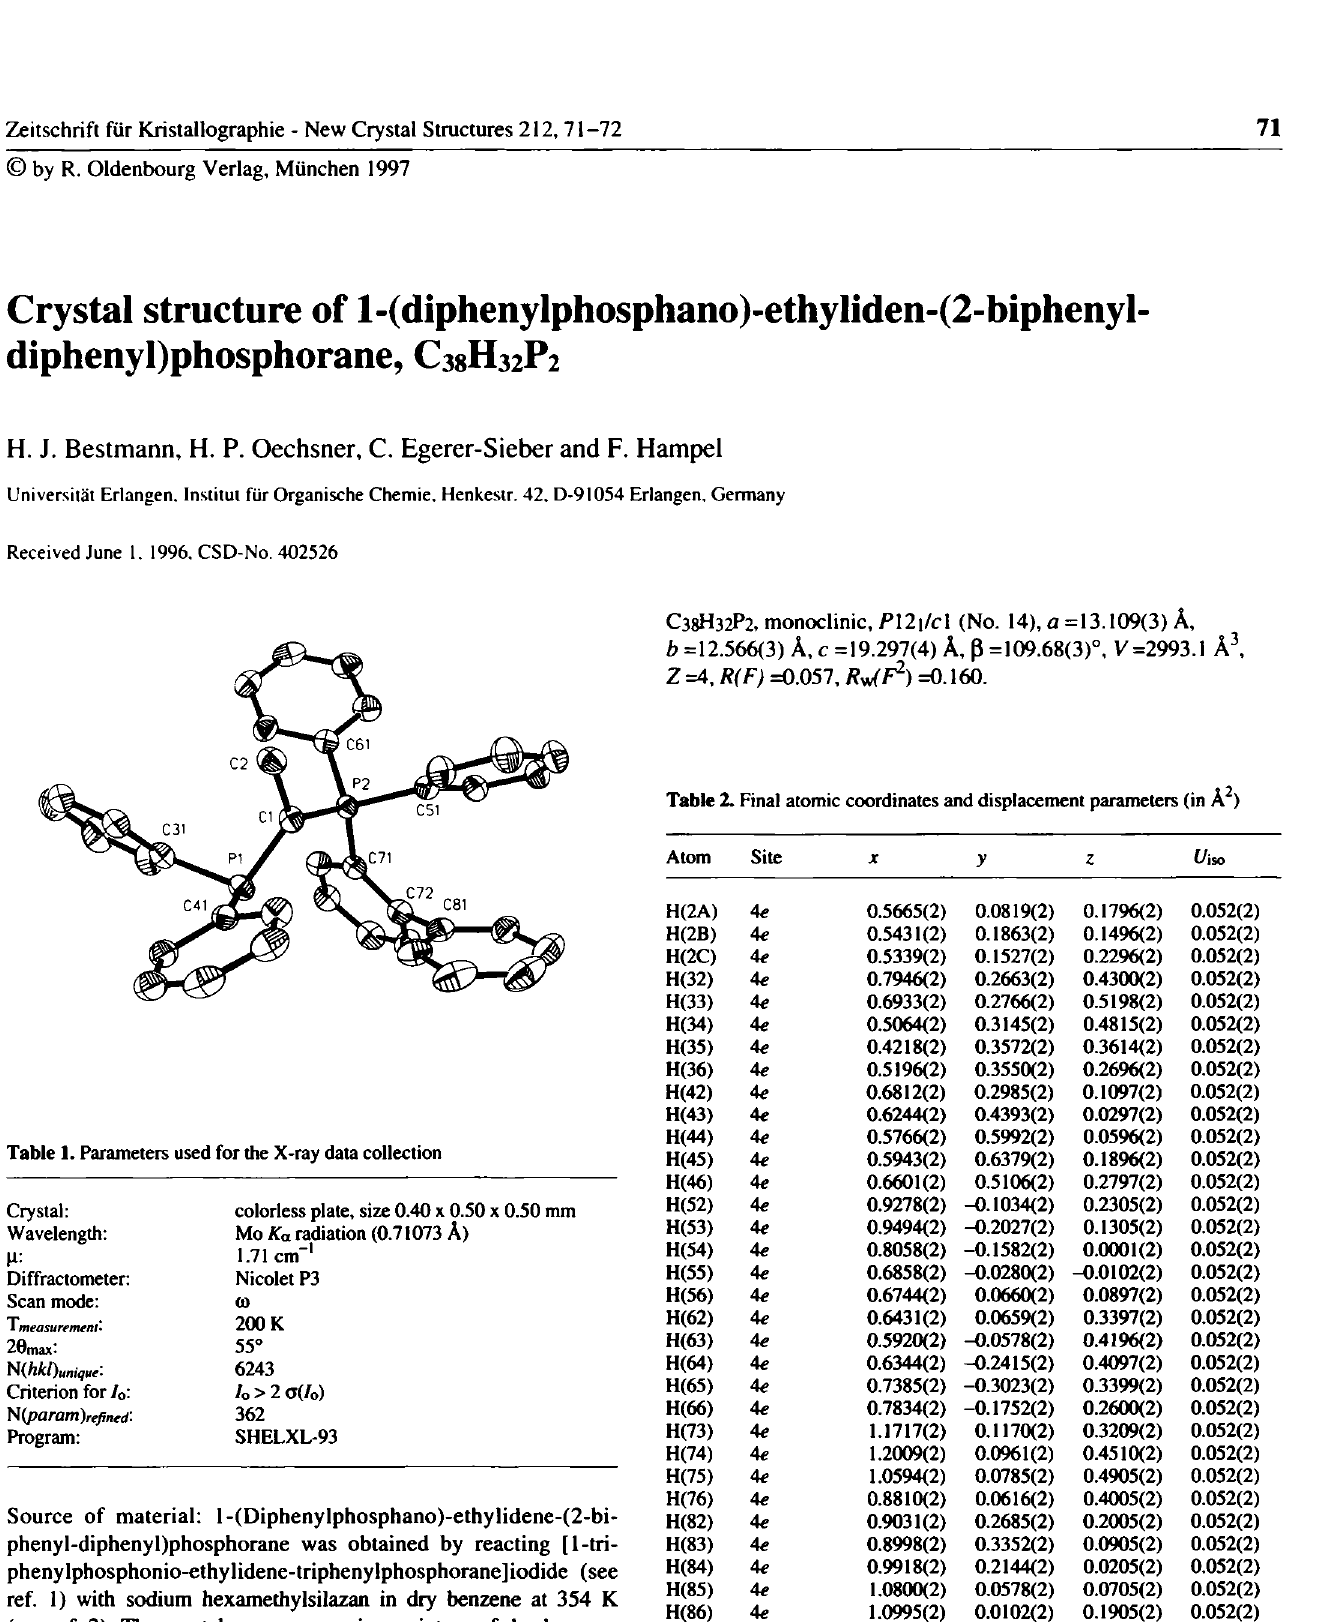
Table 3. Final atomic coordinates and displacement parameters (in Â 2 )